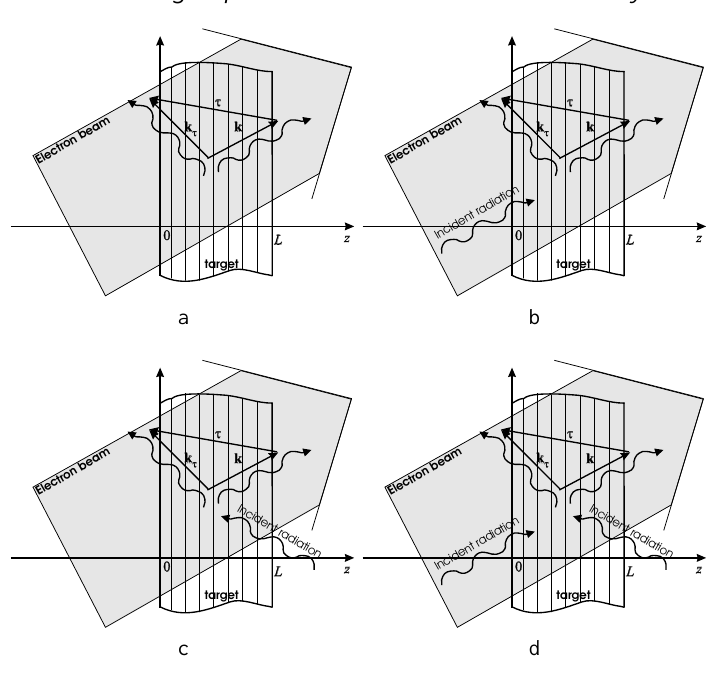
Figure 1. Scheme of quasi–Cherenkov VFEL in Bragg